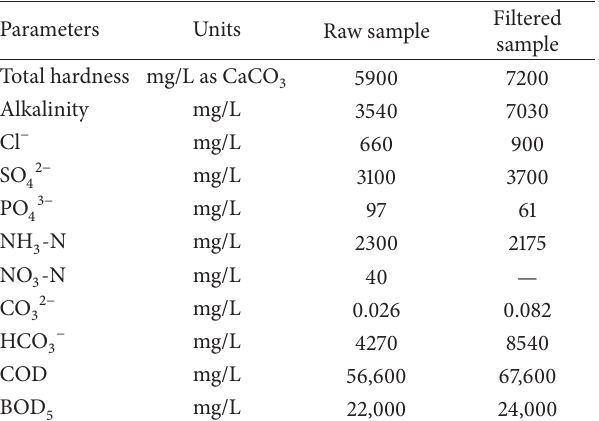
Table 2: Chemical parameters of the collected field tannery wastew- ater